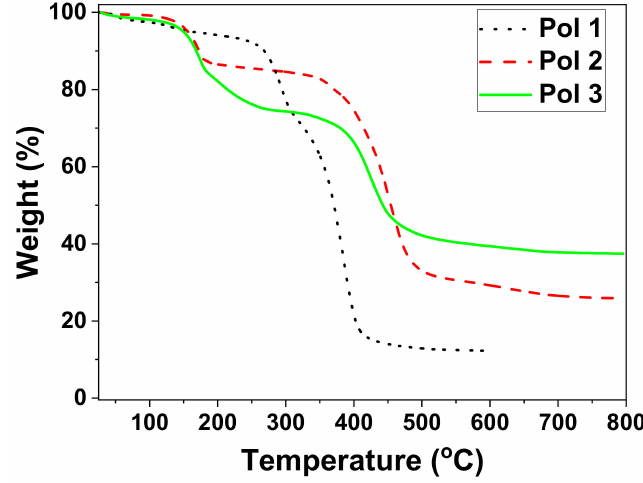
Figure 4. TGA spectra of Pol 1 (dotted line), Pol 2 (dashed line) and Pol 3 (full line) recorded by a heating rate of 10 ◦ C min − 1 under N 2